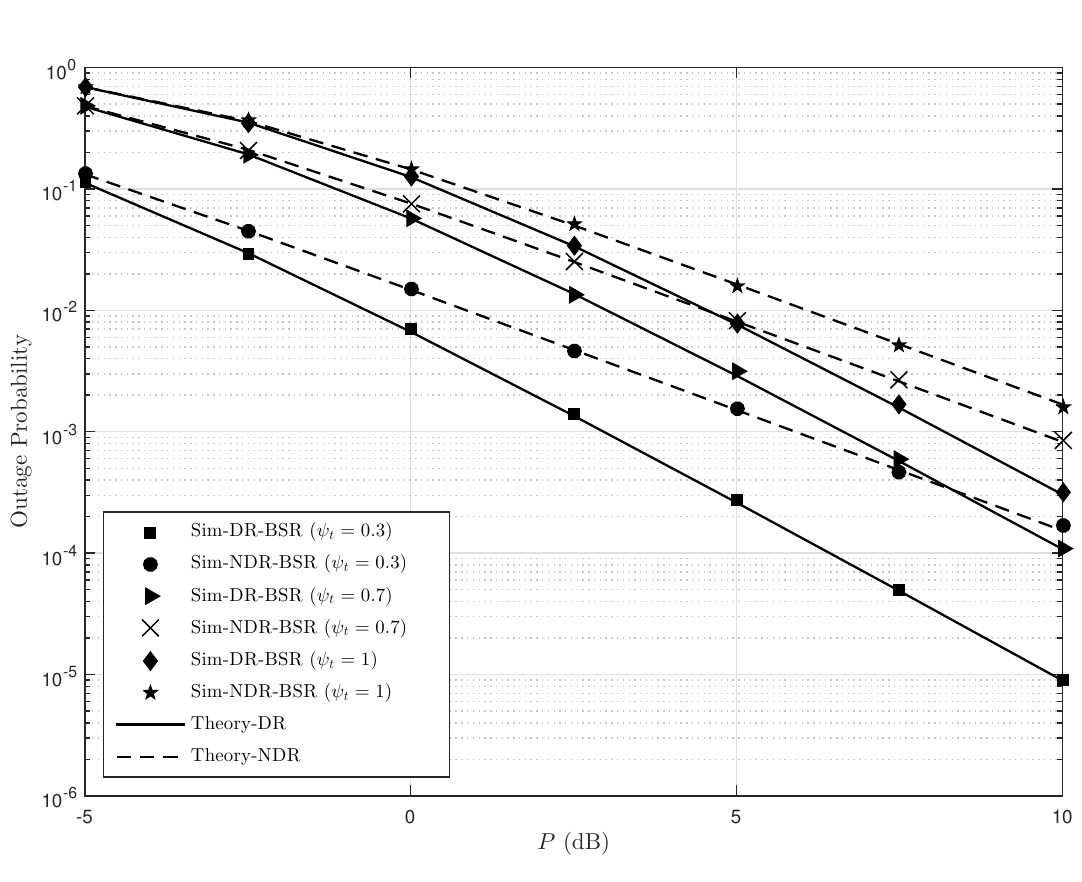
of 0.3, 0.7, and 1 t